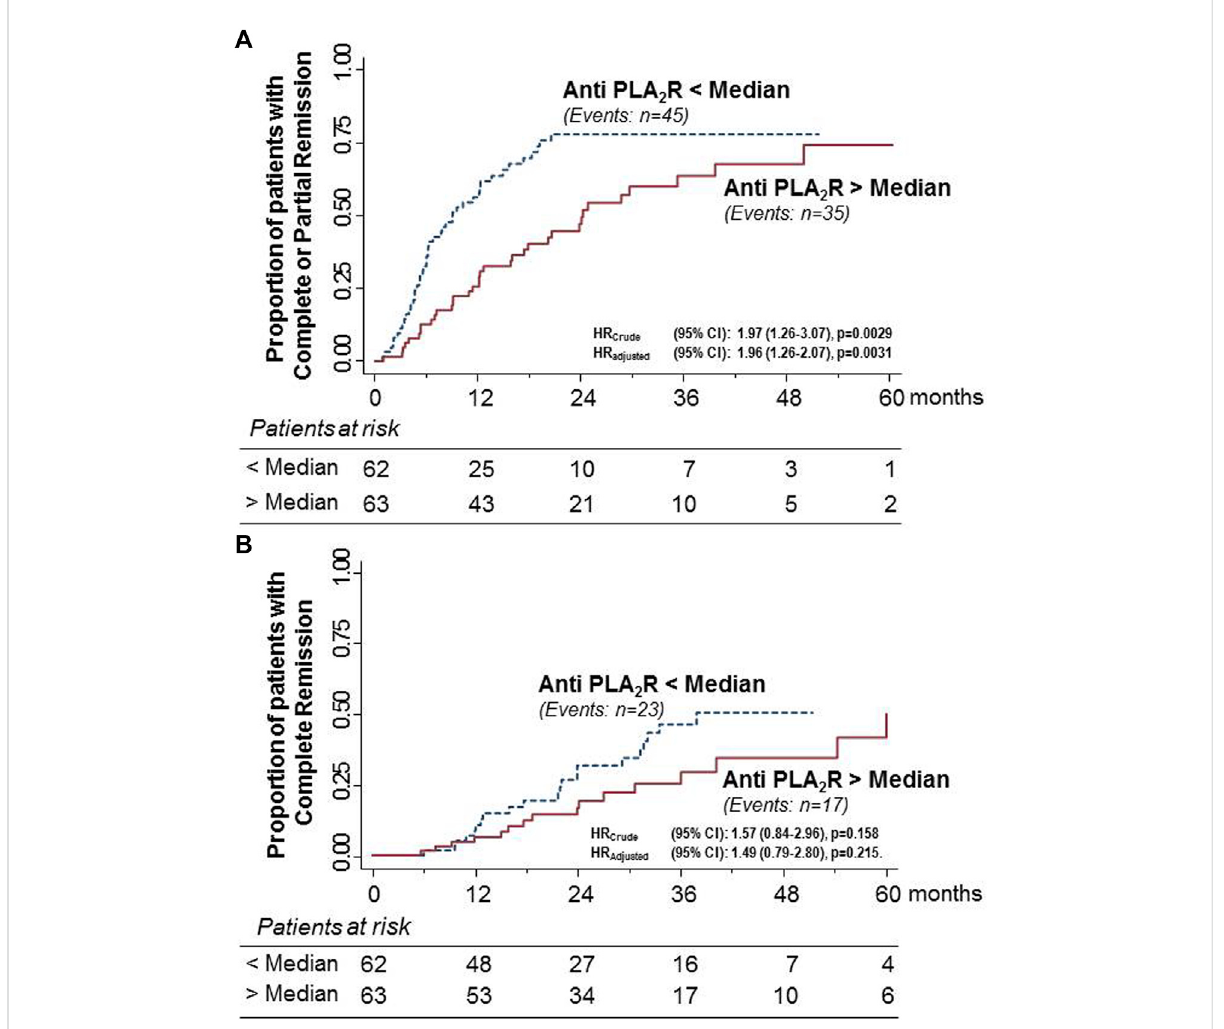
FIGURE 2 Kaplan – Meier curves for the proportion of participants with primary MN who progressed to the combined endpoint of complete or partial remission (A) ortocompleteremissionconsideredasasingleendpoint (B) inthesubgroupsofpatientswithanti-PLA 2 Rantibodytiteraboveorbelow themedianconsideredseparately.Therateofprogressiontothecombinedendpointwassigni fi cantlyhigherinfemalesthaninmales.Thedifference was signi fi cant even after adjusting for baseline serum creatinine levels. Similar but non-signi fi cant trends were observed for complete remission, considered as a single endpoint, even after adjustment for baseline serum creatinine